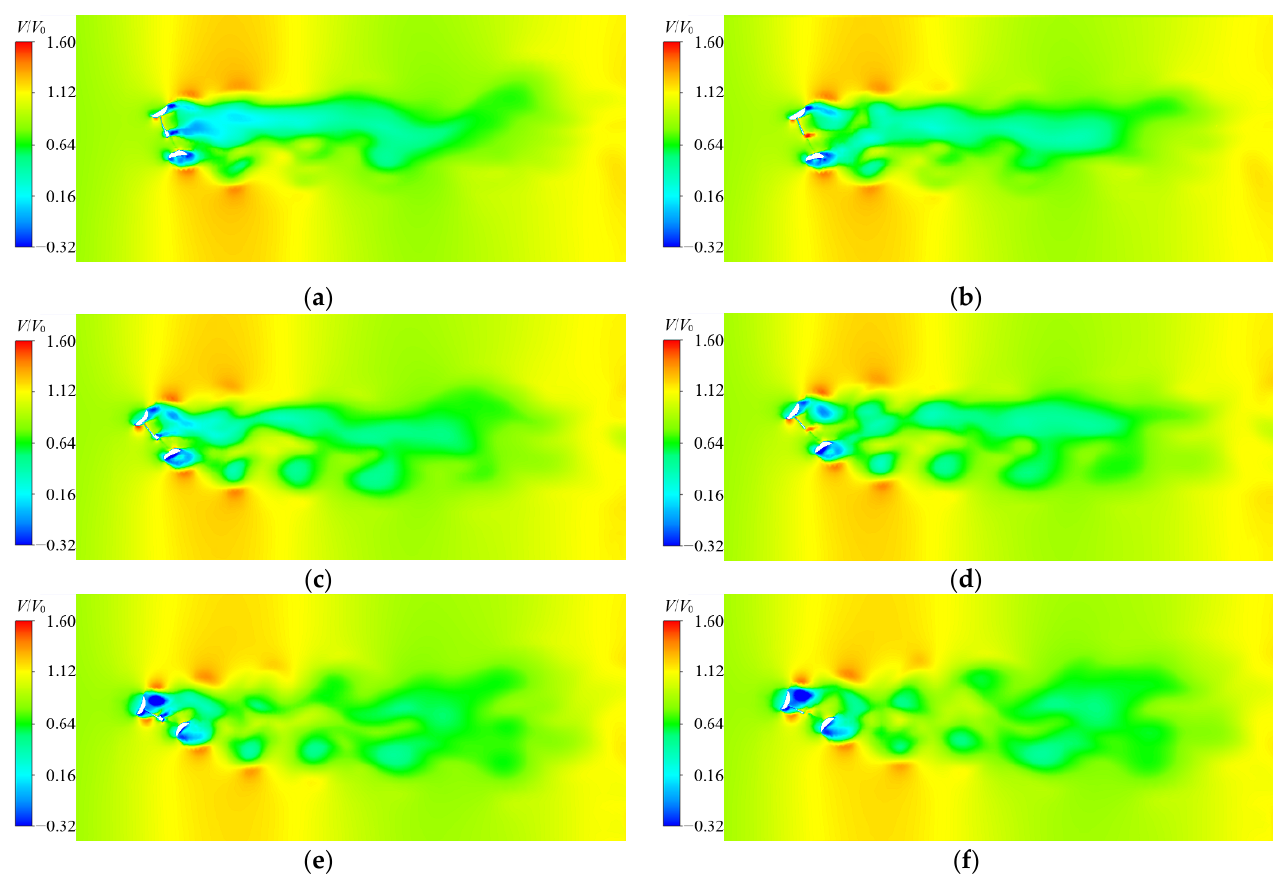
Figure 18. Axial velocity contours for the two configurations in the central x - z plane: ( a ) DT for γ = 20 ◦ ; ( b ) RDT for γ = 20 ◦ ; ( c ) DT for γ = 40 ◦ ; ( d ) RDT for γ = 40 ◦ ; ( e ) DT for γ = 60 ◦ ; ( f ) RDT for γ = 60 ◦ . The mean streamwise velocity profiles for the two configurations at TSR = 4.0 and different γ in the central x - z plane are plot in Figures 19–21. From the profiles, the wake is asymmetric about x / D = 0, especially at z / D = 0.5 and 1.0. Affected by yawed flow, there are two main minimum of velocity around x / D = ± 0.6 for the two configurations at z / D = 0.5, which is caused by the blockage effect of deflected duct. As γ increases, the upper minimum value increases and the lower minimum value decreases, and the wakes recover faster.